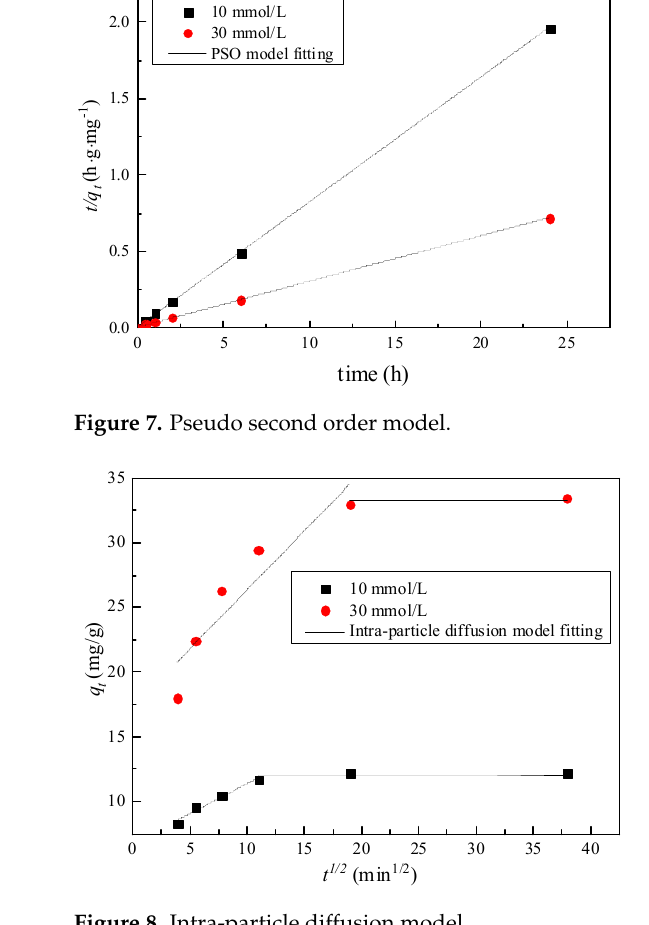
Figure 8. Intra-particle diffusion model. Table 4. Kinetic model parameters of adsorption.